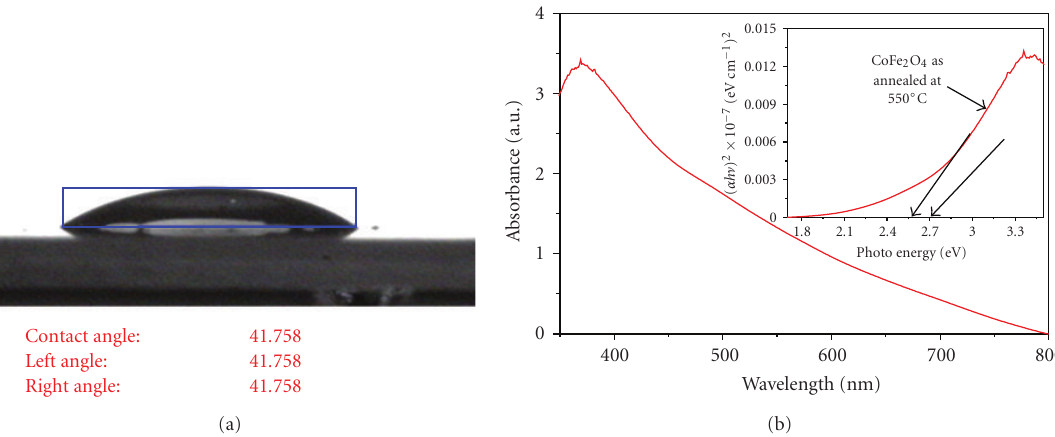
Figure 2: (a) Measurement of water contact angle, (b) Uv-Vis spectrum, and then corresponding direct band gap (inset, free arrow indicates the bulk band gap